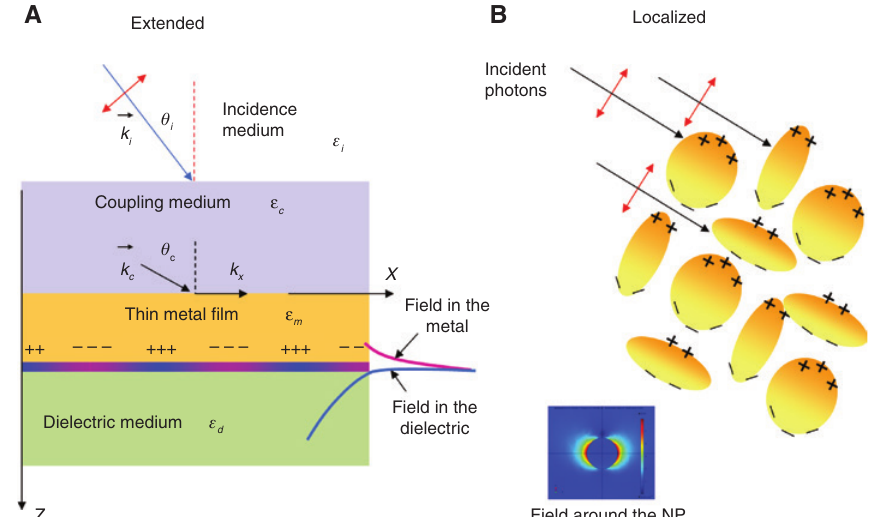
Figure 2: General excitation schemes for extended and localized surface plasmons. Scheme for exciting ESPs (A) through a coupling medium (prism, waveguide, fiber or grating) and for exciting LSPs (B) by direct excitation